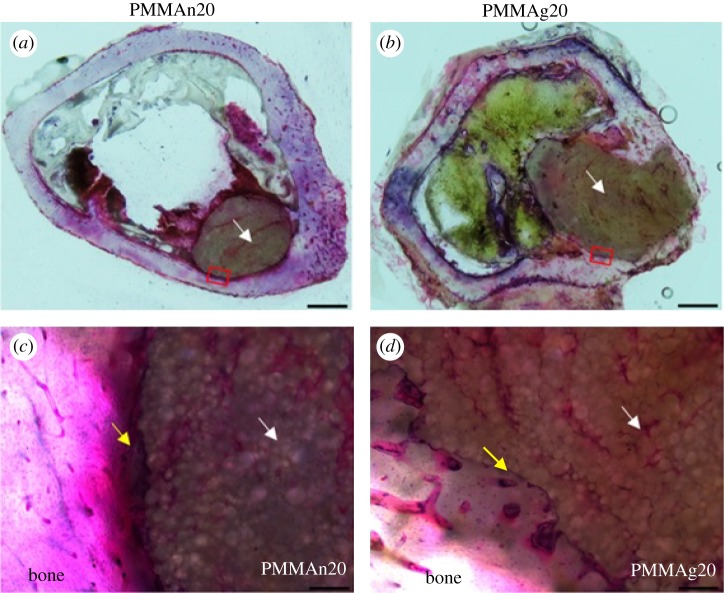
Histological images of bone tissue with PMMAn20 (a) and PMMAg20 (b) implanted after three months. The implanted cement was marked with a white arrow (scale bar 1000 µm). Magnified images of the red squares on PMMAn20 and PMMAg20 composite cements are shown in (c) and (d), respectively. PMMAn20 was separated from the host bone by a layer of fibrous tissue (yellow arrow); whereas, PMMAg20 had a tight connection to the surrounding bone tissue, which revealed better bone ingrowth (scale bar 20 µm).